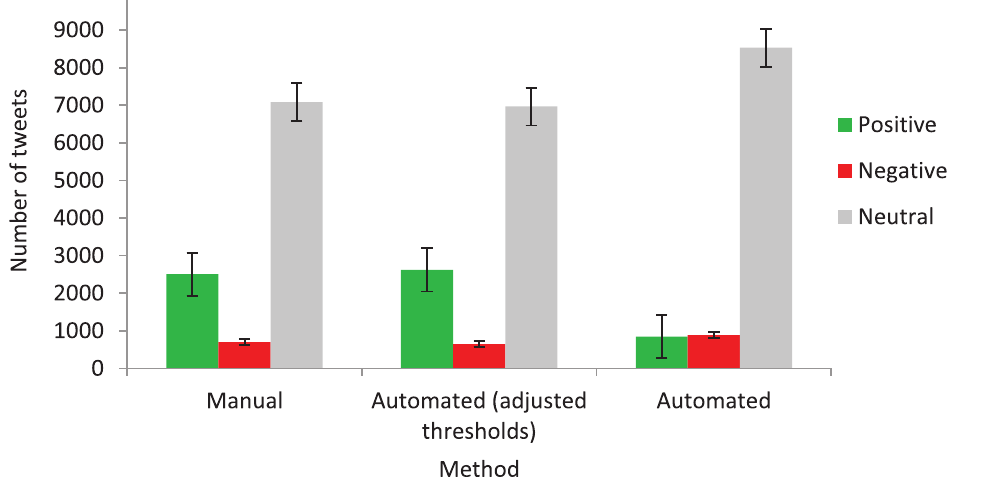
Figure 4. Comparisons of the numbers of tweets assigned to positive, neutral and negative categories by the manual and automated methods using two different